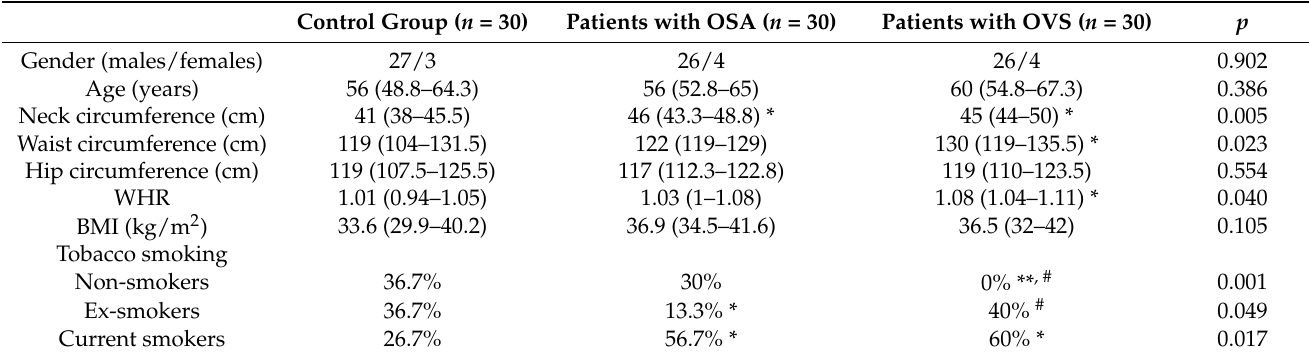
Table 1. Comparison of anthropometric characteristics between control, obstructive sleep apnea (OSA) and overlap syndrome (OVS) groups.